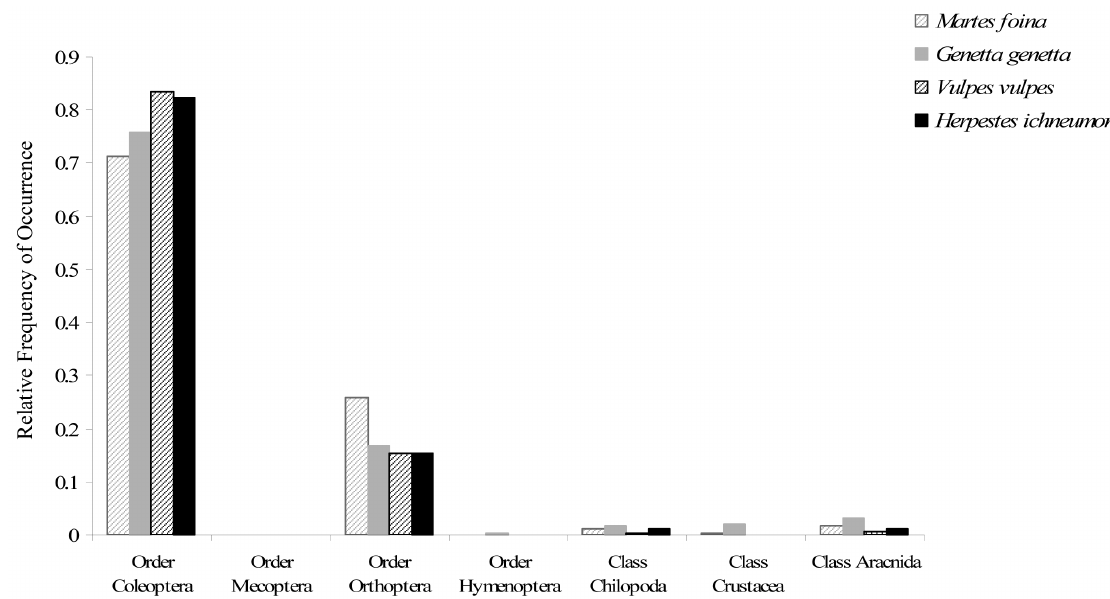
Fig. 2. Relative frequency of occurrence of arthropods consumed by four carnivores in SW Portugal (Insecta: order Coleoptera, order Mecoptera, order Orthoptera, and order Hymenoptera; Chilopoda, Crustacea and Aracnida) consumed by common genets, Egyptian mongooses, stone martens and red foxes.